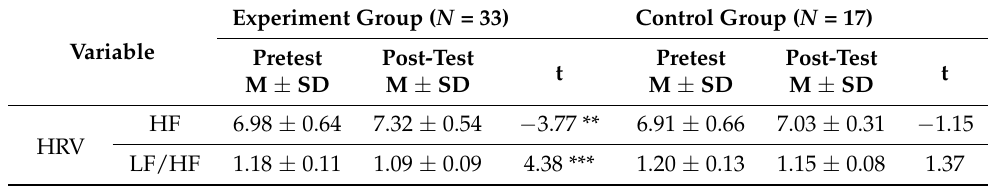
Table 4. Comparison of HRV pre- and posttests between the experimental and control group.